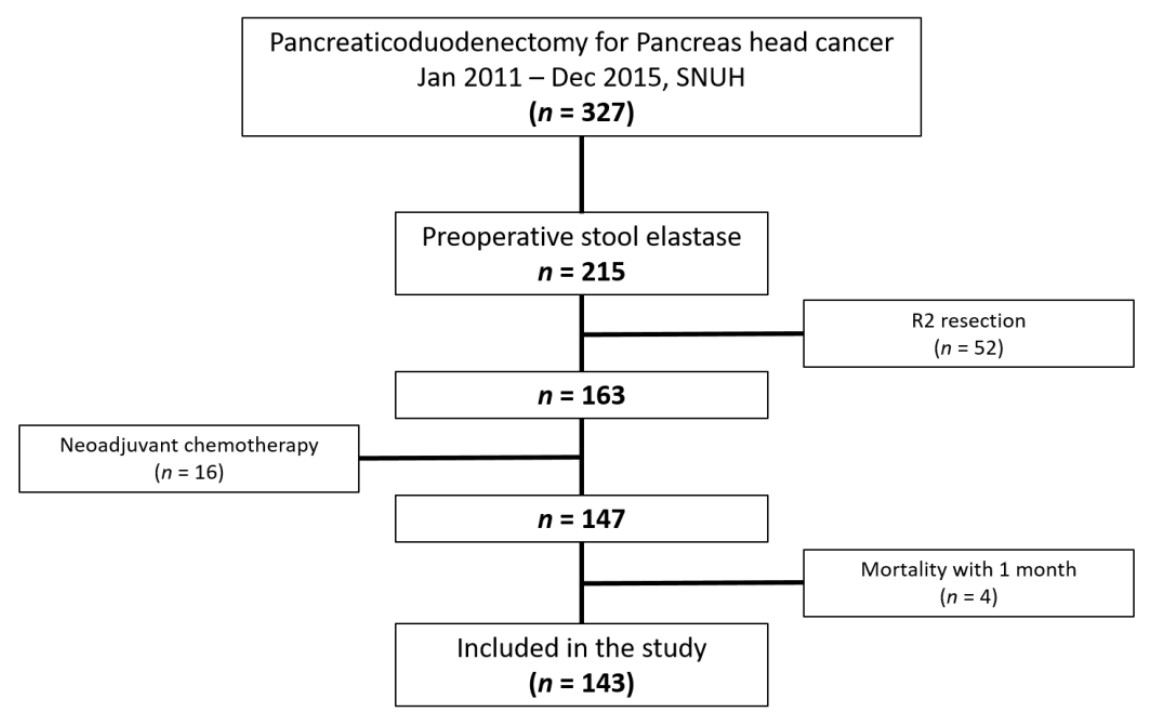
Figure 1. Flowchart of patient selection.